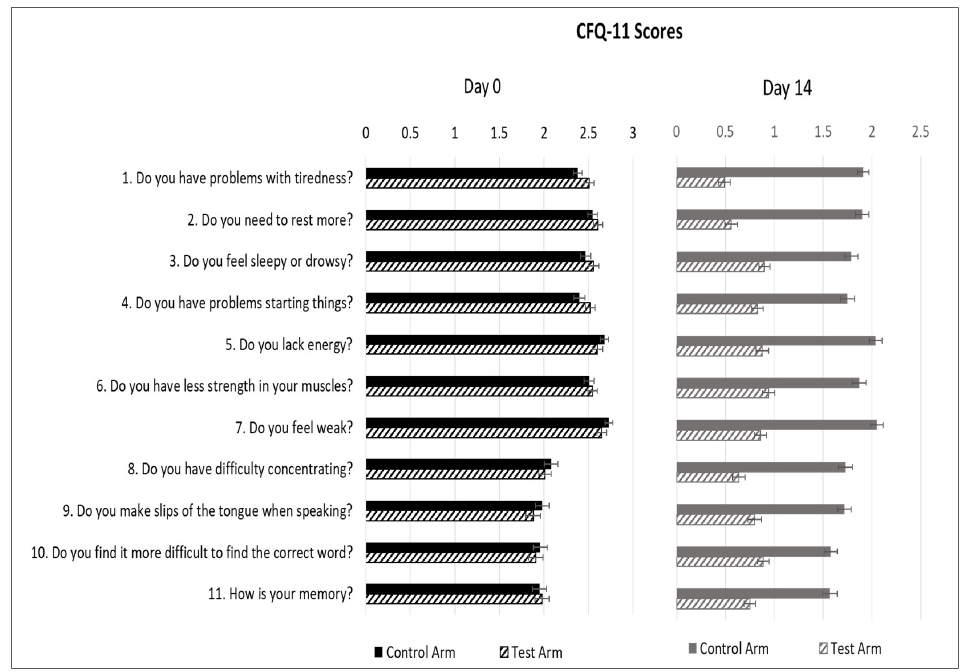
Figure 4. Average CFQ-11 scores of individual measures of fatigue of subjects in the control and test arms on day 0 and day 14 of the treatment period All data are presented as mean ± SEM ( n =